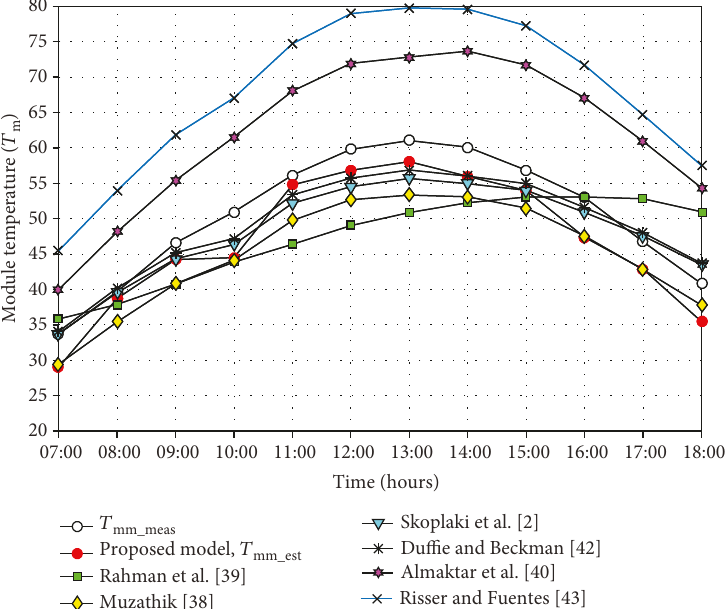
Figure 13: Proposed model estimation versus measured data and other existing model module temperature values of monocrystalline module during